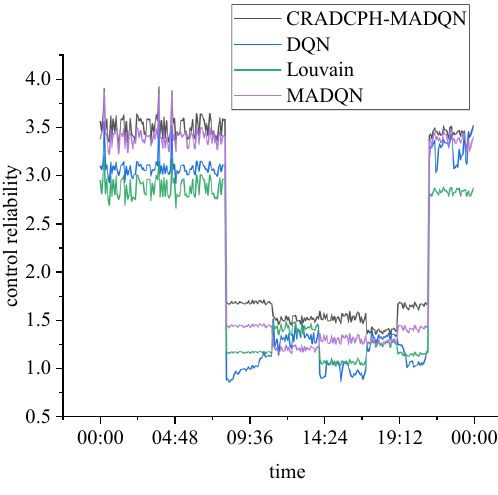
Figure 5. Control reliability.